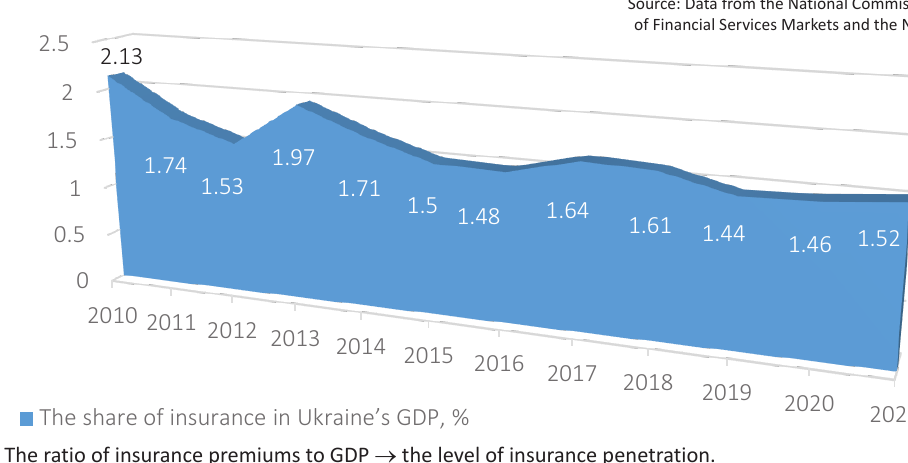
Figure 4. The share of insurance in Ukraine’s GDP in 2010–2020*,